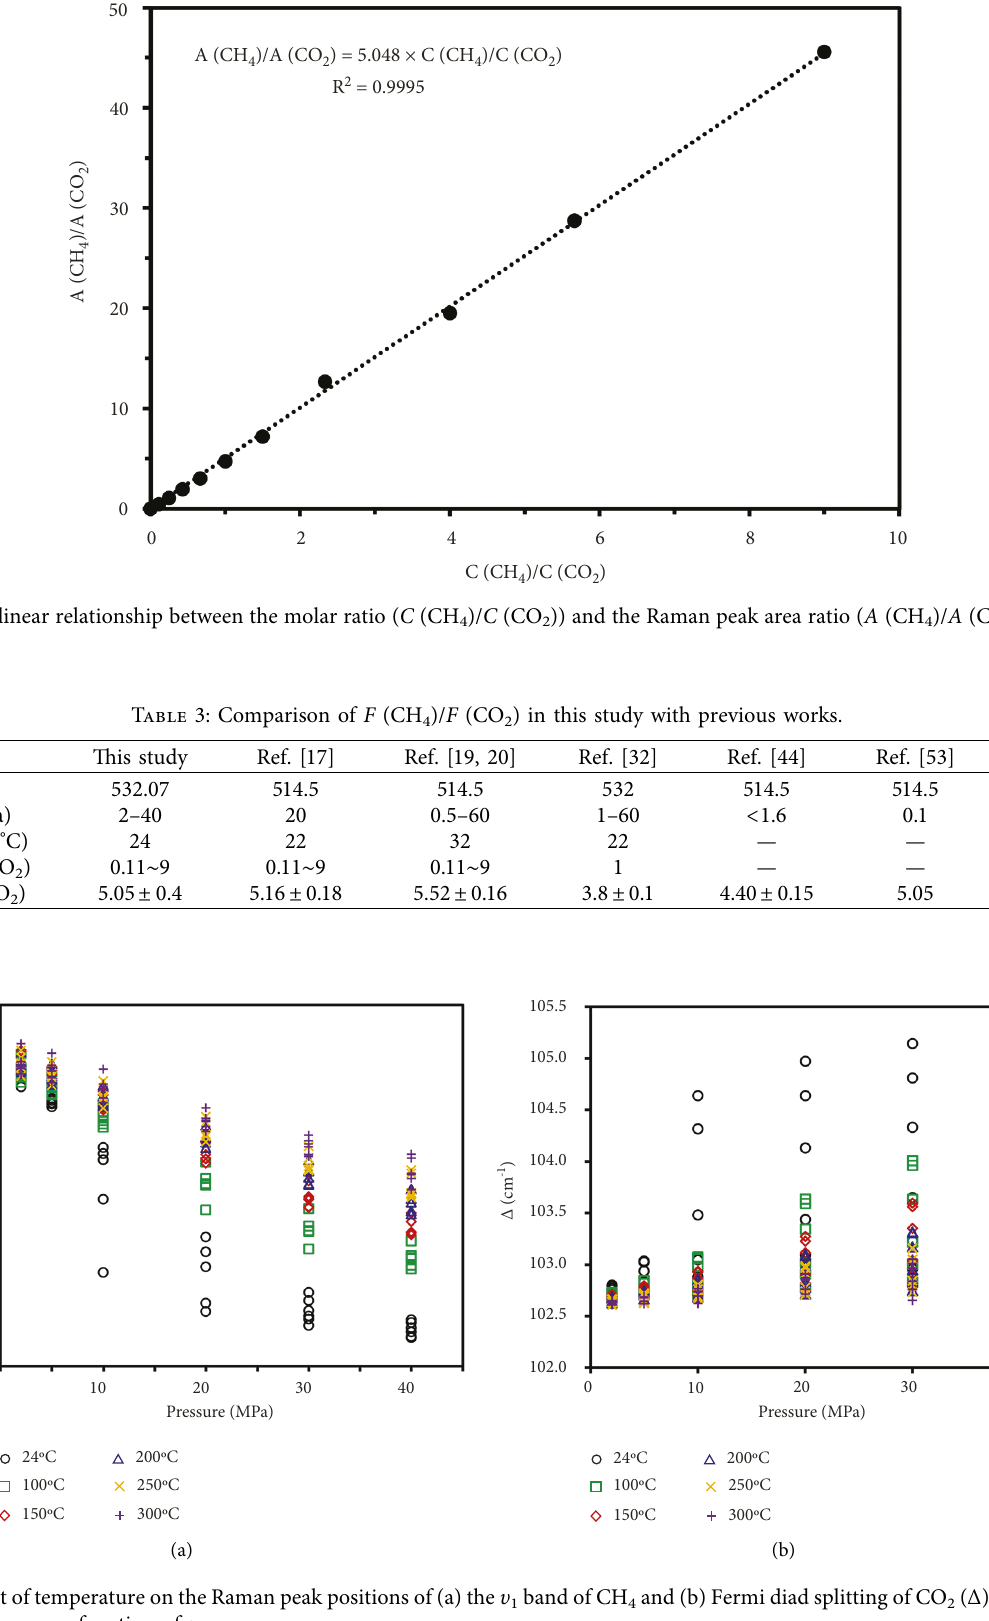
1 band of CH 4 and (b) Fermi diad splitting of CO 2 ( Δ ) for five CO 2 -